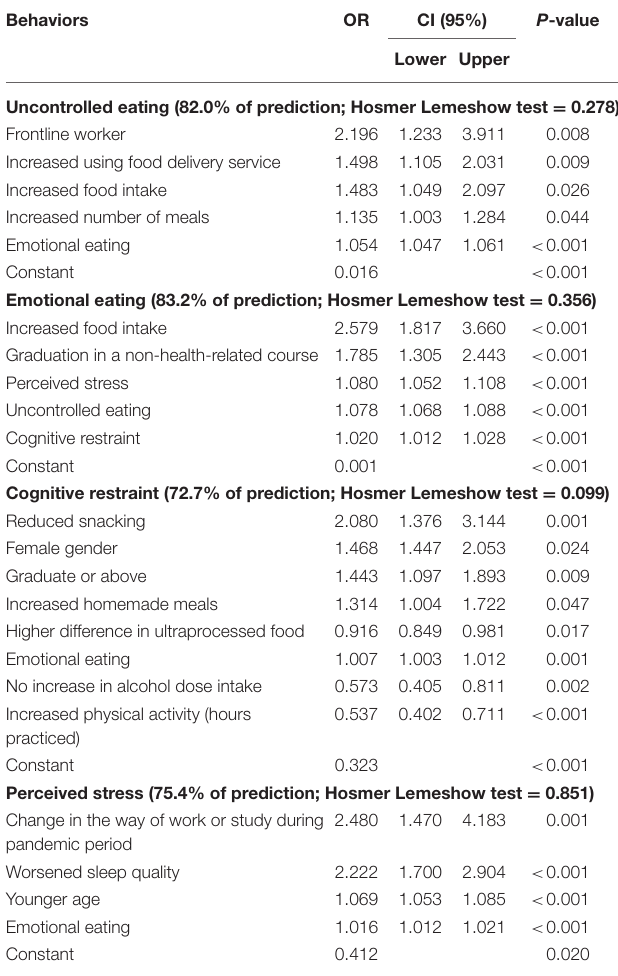
FIGURE 2 | Stress score; (B) Difference of candies consumption among Brazilian who were below and above the 3rd Quartile of Cognitive Restraint score; (C) Difference of instant meals and snacks consumption among Brazilian who were below and above the 3rd Quartile of Cognitive Restraint score; (D) Difference of bakery products consumption among Brazilian who were below and above the 3rd Quartile of Cognitive Restraint score; (E) Difference of sugary drinks consumption among Brazilian who were below and above the 3rd Quartile of Emotional Eating score; (F) Difference of instant meals and snacks consumption among Brazilian who were below and above the 3rd Quartile of Emotional Eating score; (G) Difference of candies consumption among Brazilian who were below and above the 3rd Quartile of Emotional Eating score; (H) Difference of fast-food consumption among Brazilian who were below and above the 3rd Quartile of Emotional Eating score; (I) Difference of instant meals and snacks consumption among Brazilian who were below and above the 3rd Quartile of Uncontrolled Eating score; (J) Difference of candies consumption among Brazilian who were below and above the 3rd Quartile of Uncontrolled Eating score; (K) Difference of cereals consumption among Brazilian who were below and above the 3rd Quartile of Uncontrolled Eating score; (L) Difference of canned products consumption among Brazilian who were below and above the 3rd Quartile of Uncontrolled Eating score; (M) Difference of vegetables consumption among Brazilian who were below and above the 3rd Quartile of Uncontrolled Eating score; (N) Difference of sugary drinks consumption among Brazilian who were below and above the 3rd Quartile of Uncontrolled Eating score; (O) Difference of fast-food consumption among Brazilian who were below and above the 3rd Quartile of Uncontrolled Eating score.